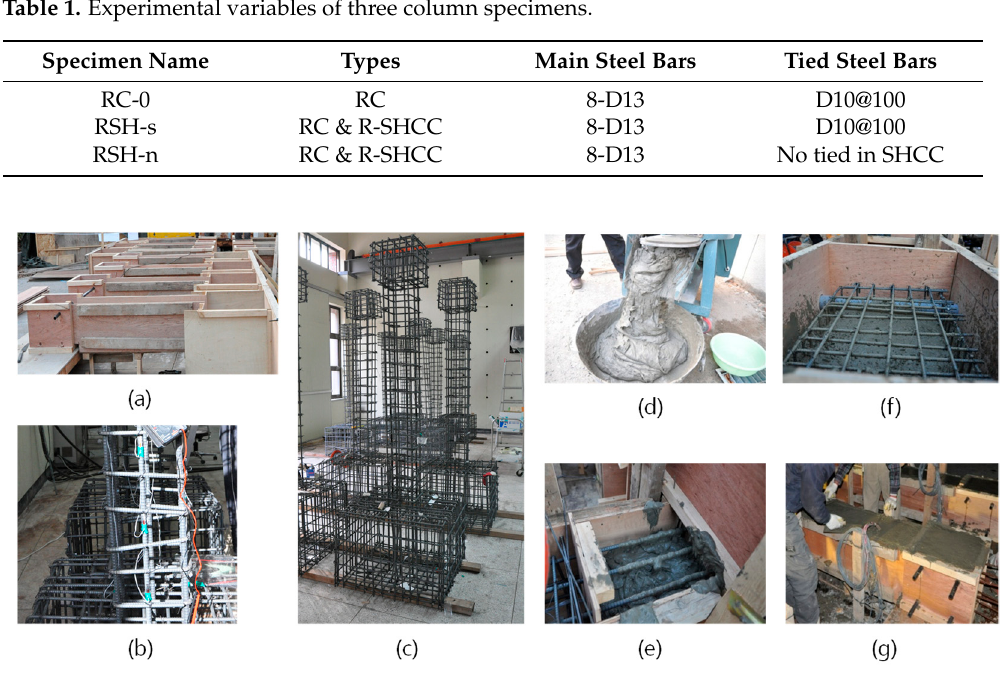
Figure 4. Manufacturing process of column specimens: ( a ) Wood formwork; ( b ) Steel gauges; ( c ) Reinforcements; ( d ) Fresh SHCC; ( e ) Placing SHCC; ( f ) Placing concrete; ( g ) Finishing.